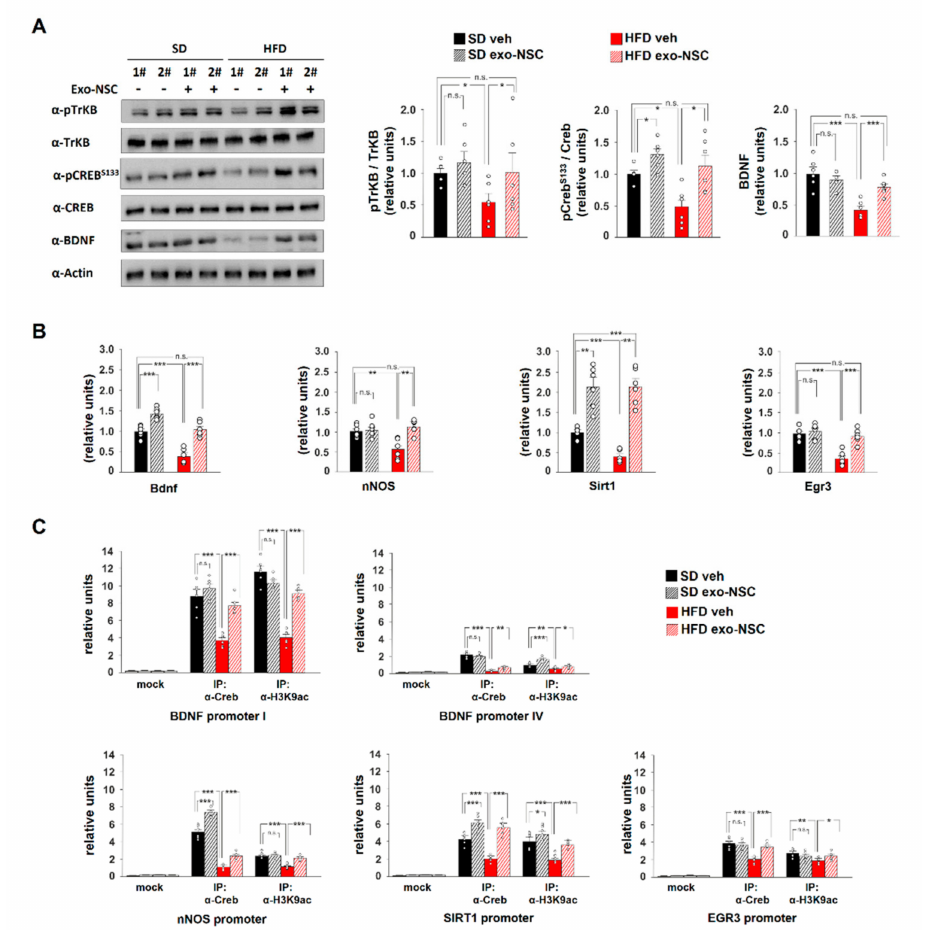
Figure 4. exo-NSCs restore CREB transcriptional activity in the hippocampus. ( A ) Immunoblot analysis and bar graphs showing the levels of BDNF, pTrkB T816 and pCreb S133 in mice intranasally treated with saline (vehicle) or exo-NSC and fed for 6 weeks with either SD or HFD (SD veh , SD exo-NSC , HFD veh , HFD exo-NSC , respectively; n = 6 mice per experimental group; statistics using two-way ANOVA and Bonferroni post hoc). ( B ) mRNA expression of Bdnf, nNos, Sirt1 and Egr3 in the hippocampus of SD veh , SD exo-NSC , HFD veh and HFD exo-NSC mice. Real-time analysis was performed in triplicate. The experiment was repeated six times using independent RNA samples ( n = 6 mice per experimental group; statistics using two-way ANOVA and Bonferroni post hoc). ( C ) ChIP assays of both CREB and H3K9ac on the promoters of Bdnf, nNos, Sirt1 and Egr3 genes in the hippocampus of SD veh , SD exo-NSC , HFD veh and HFD exo-NSC mice. Real-time analysis was performed in triplicate ( n = 6